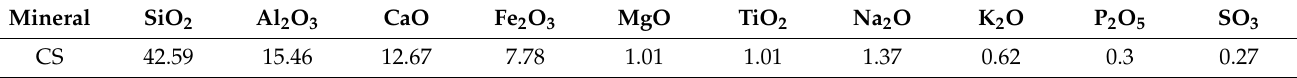
Table 1. Chemical compositions of CS (%